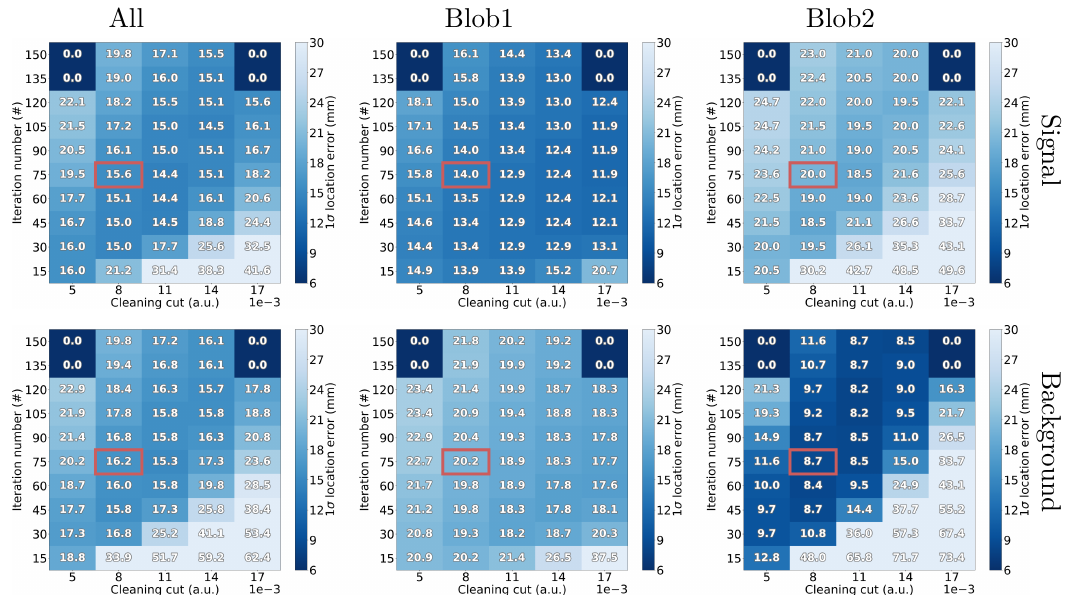
Figure 19 . Blob location error distance for the RL parameter scan for MC events. The first column shows the overall value while the second and third columns show the blob1 and blob2 distribution respectively. The result for the optimal configuration is marked in red. Top row: signal events within the double escape peak ROI. Bottom row: background events in the same